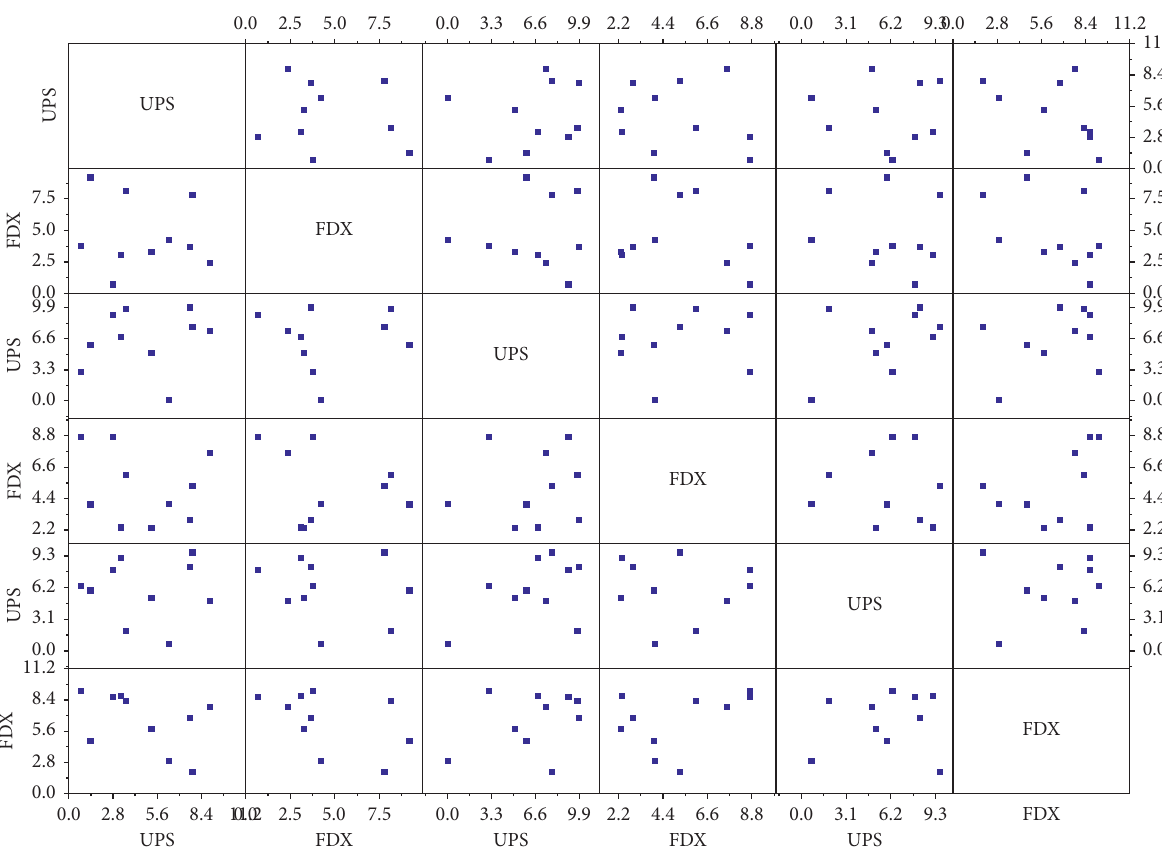
Figure 4: Scatter plot of shipping and coordination categories.